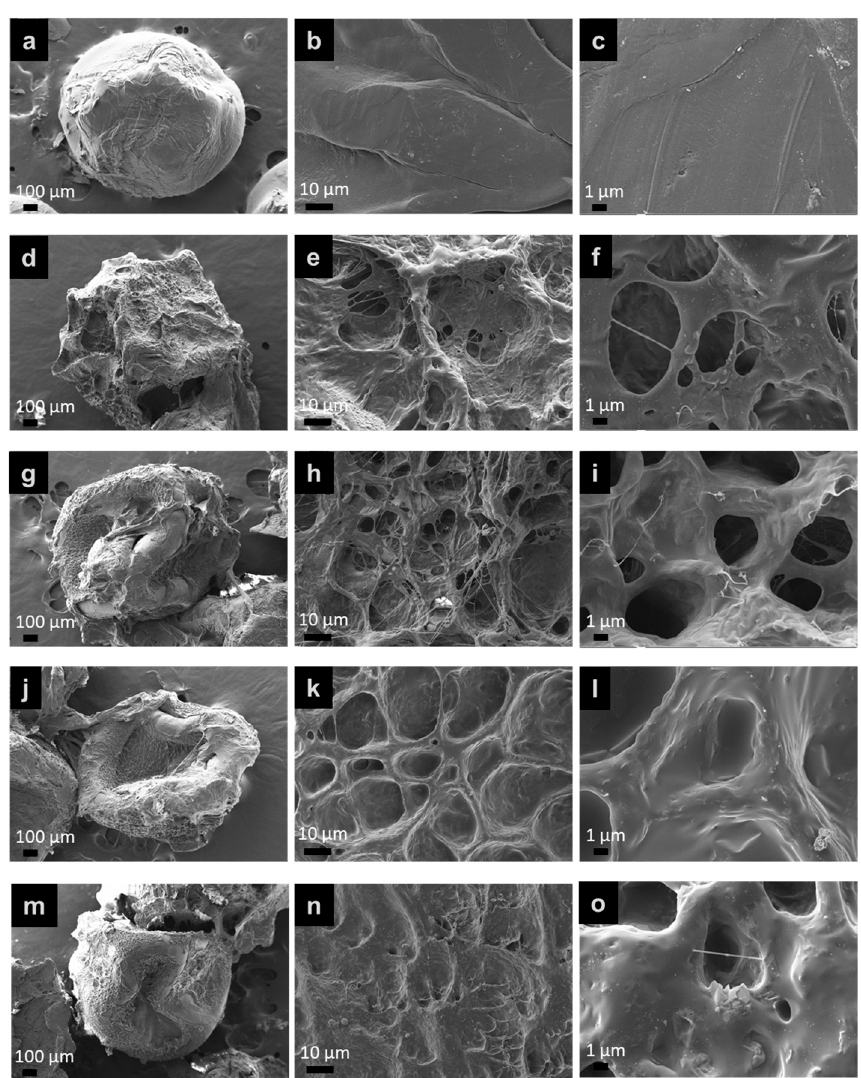
Figure 12. SEM images of ( a – c ) CS beads; ( d – f ) M0.50/P30-DPNR-coated CS beads; ( g – i ) M0.50/P30- DPNR/Si10-coated CS beads; ( j – l ) M0.50/P30-DPNR/Si20-coated CS beads and ( m – o ) M0.50/P30- DPNR/Si30-coated CS beads at ×50, ×1000 and ×10,000 magni fi cations.